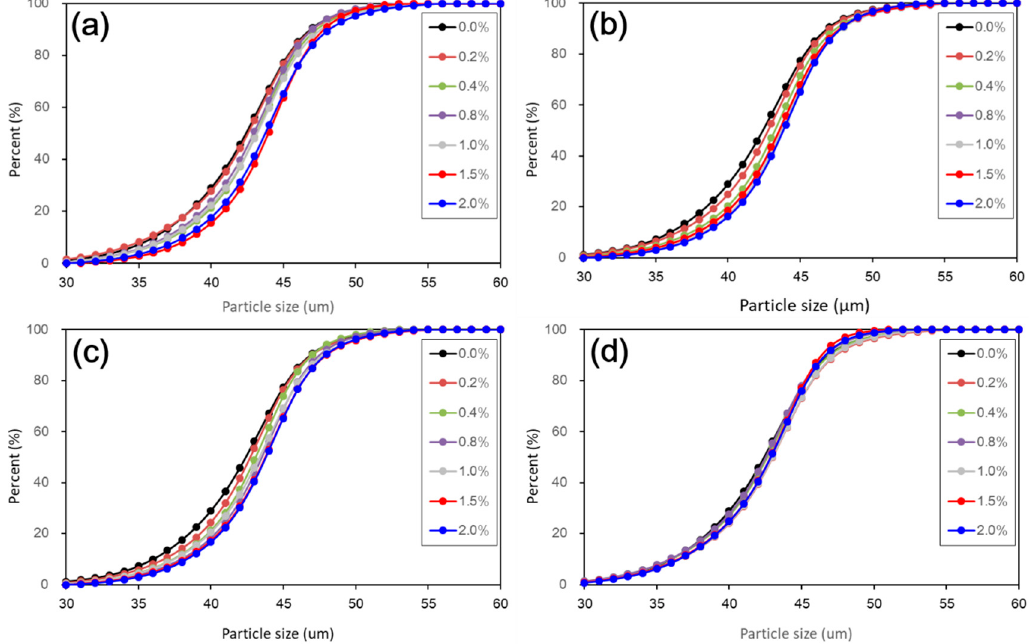
Figure 6. Effect of nano-SiO 2 content and curing duration on cumulative particle size distribution of treated loess. ( a ) 7 days, ( b ) 14 days, ( c ) 28 days, and ( d ) 60 days.